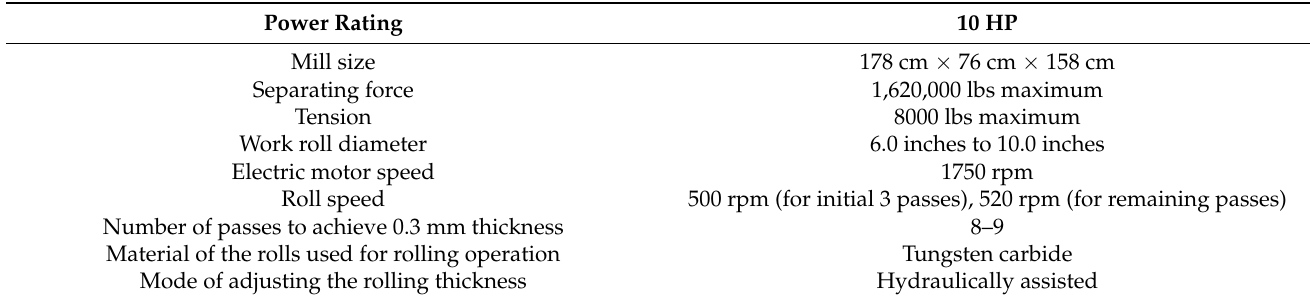
Table 3. Rolling mill parameter details.